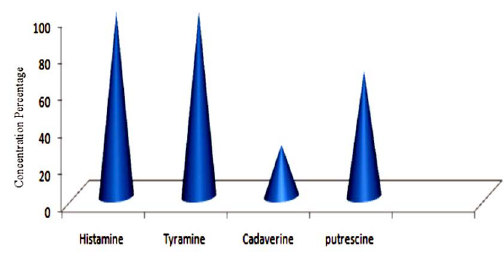
Fig. 9. Graphical representation of degradation of BAs by L.